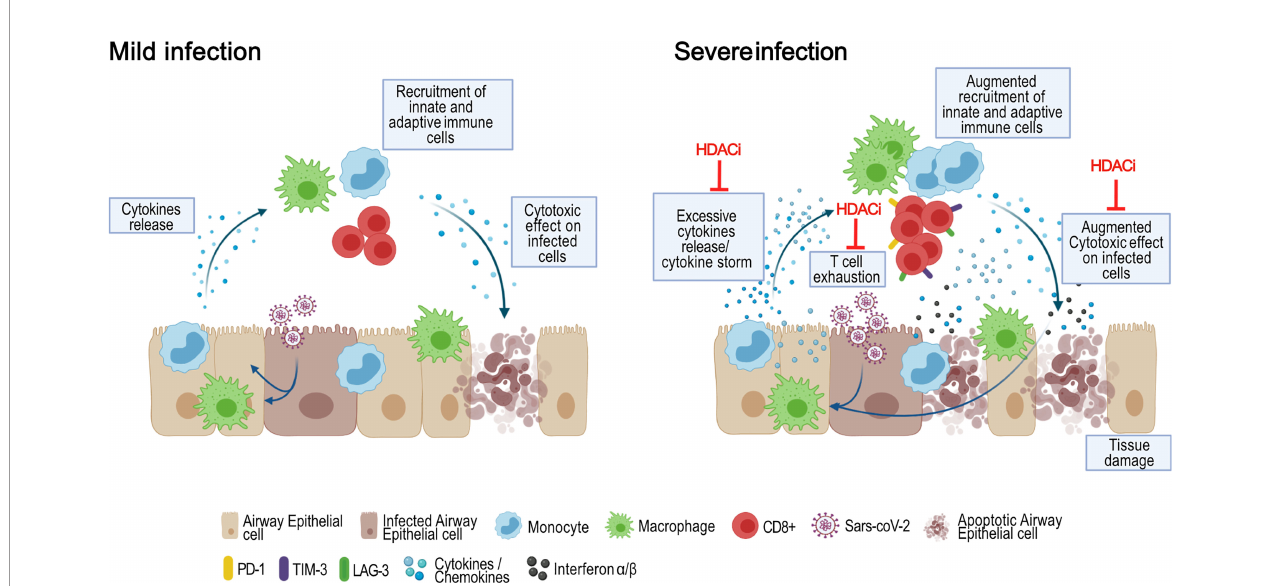
FIGURE 8 | Schematic overview of the pathogenesis and outcomes of COVID-19 and potential therapeutic effects of HDACi. In mild Sars-CoV-2 infection cases, infected airway epithelial cells recall and activate monocytes and resident macrophages through the release of cytokines and chemokines. These cells, in turn, trigger a speci fi c innate immune response to eliminate the pathogen. The increase in pro-in fl ammatory signals foster the recruitment of adaptive immune cells, including CD4 + and CD8 + T cells. This immune response leads to the elimination of the infected cells, viral clearance and resolution of the disease. In severe infections instead, a dysfunctional immune response characterized by an excessive in fi ltration of monocytes and macrophages, lymphopenia and increased T cell exhaustion, lead to unaffected viral elimination and lung tissue damage. Moreover, the hyperproduced cytokines circulate to other organs, causing multi-organ damage. In this context, HDACi act at multiple levels: i) reducing cytokines release by epithelial cells, monocytes and macrophages; ii) inhibiting the pro-in fl ammatory effects of IFN-I iii) reducing monocyte activation and T cell exhaustion and promoting T cell differentiation versus a T central memory phenotype. Created with